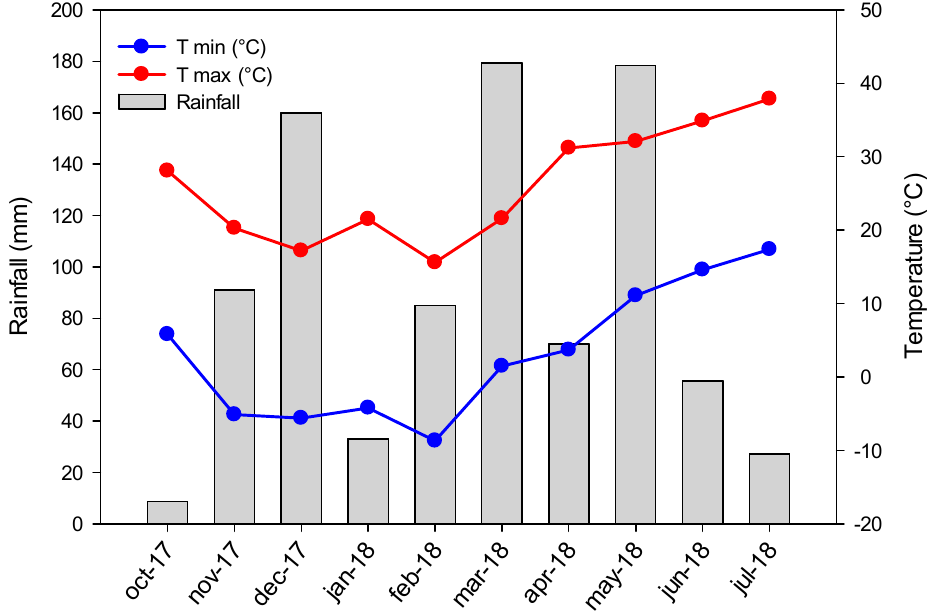
Figure 3. Rainfall, and the minimum and maximum temperature during the grown of Arundo plants.